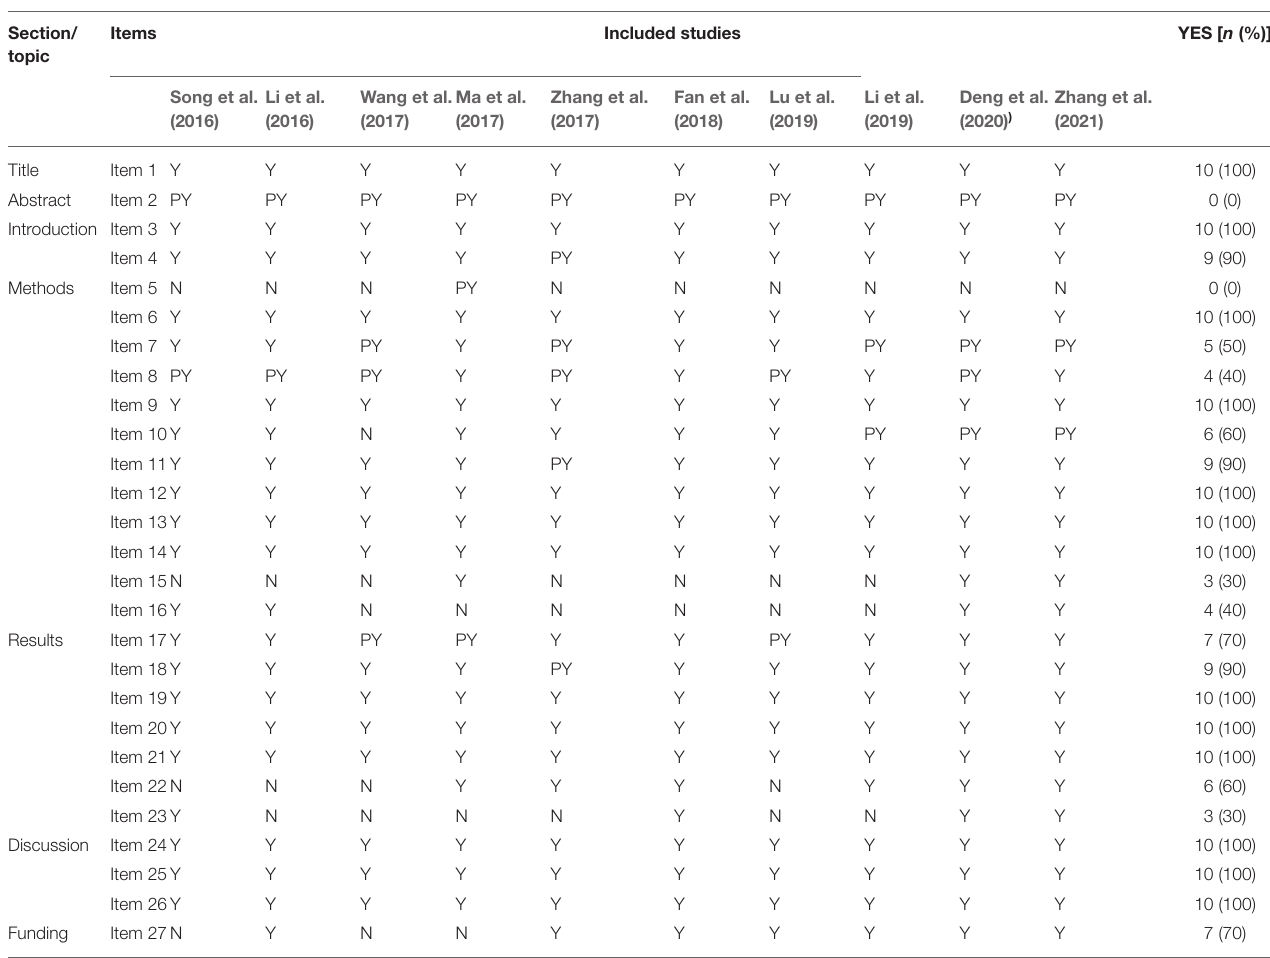
TABLE 3 | The quality assessment results of the PRISMA